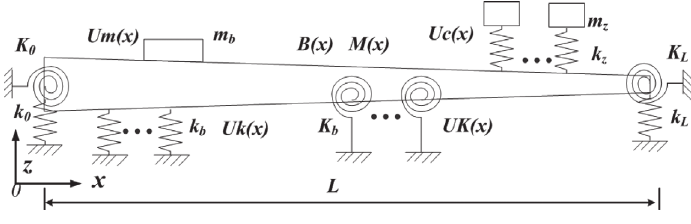
Fig. 1. Vibrating mechanical system of varying cross-section beam with